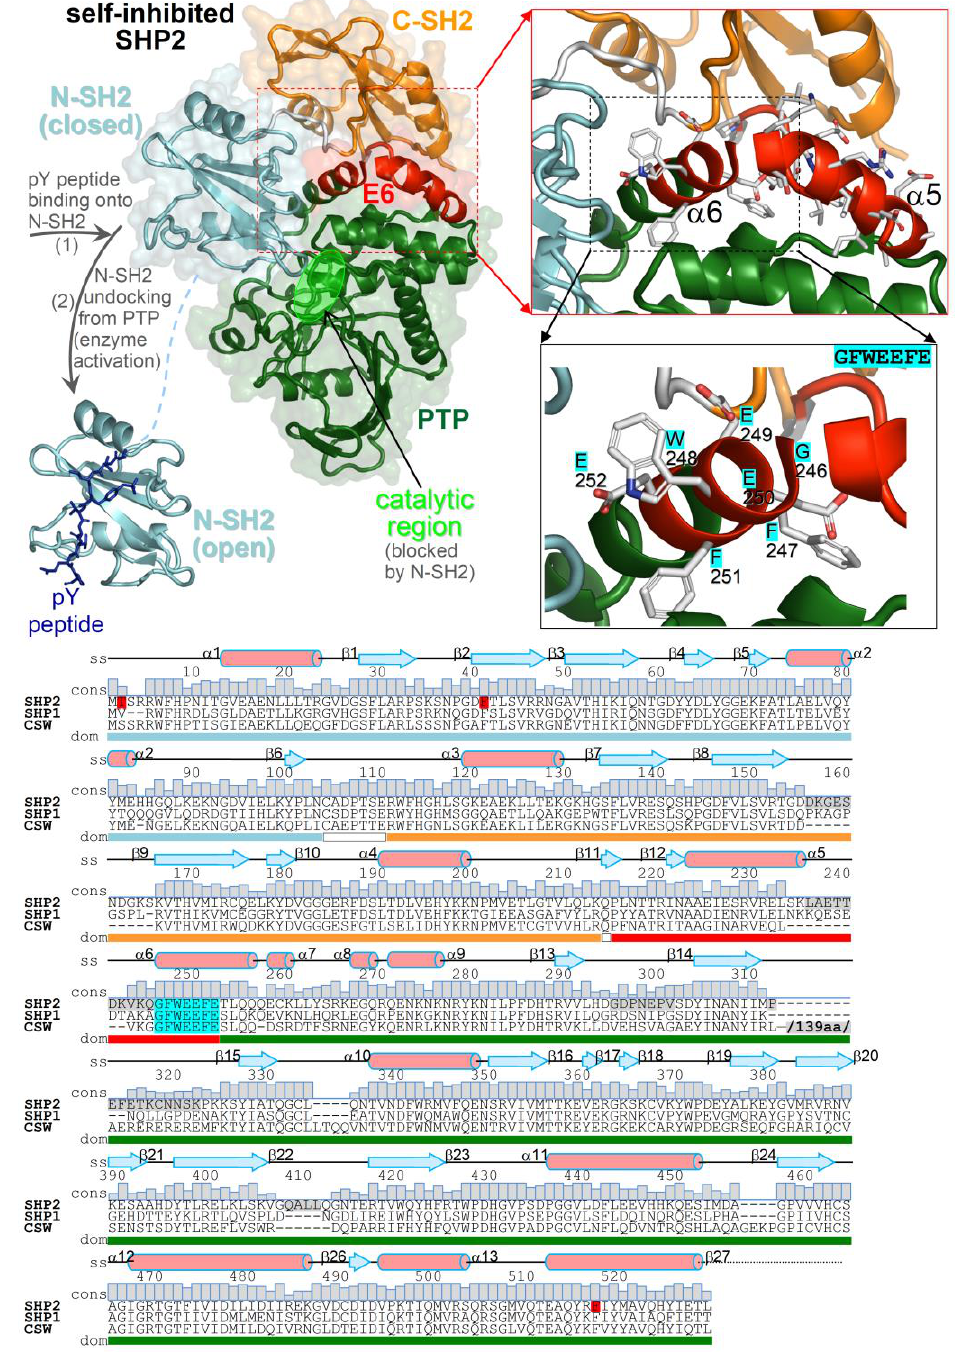
Figure 1. Structure of SHP2 and multiple-sequence alignment of tyrosine phosphatases characterized by the same tandem SH2 domain architecture (SHP2, SHP1, and corkscrew). ( top ) Crystal structures of the self-inhibited SHP2 (Protein Data Bank (PDB) 2SHP) and the isolated N-SH2 domain of